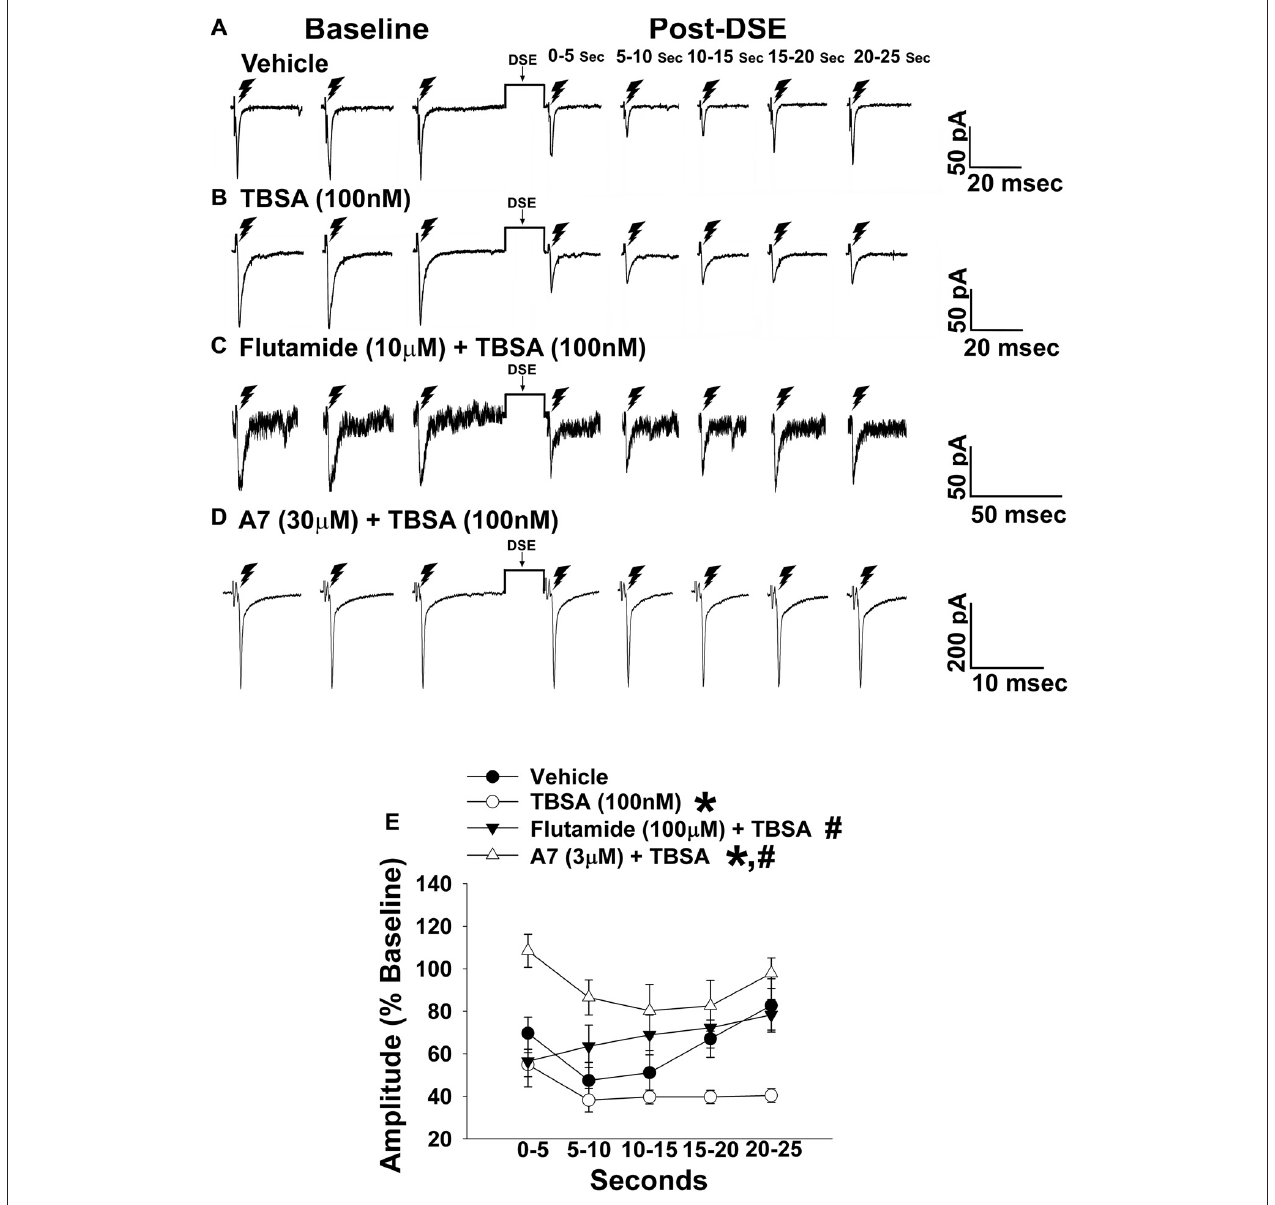
FIGURE 4 | The membrane-impermeant form of testosterone rapidly intensifies endocannabinoid (EC)-mediated reduction in eEPSC amplitude, which is blocked by a classical androgen receptor antagonist, as well as via inhibition of calcium/calmodulin-dependent protein kinase. Current membrane traces showing the decrease in eEPSC amplitude caused by postsynaptic depolarization seen in slices treated with either vehicle ( A ; n = 6) or testosterone 4-androsten-17 µ ;-ol-3-one-3 carboxymethyloxime bovine serum albumin (TBSA; 100 nM; B ; n = 8). Bath application of flutamide (10 µ M) attenuated the rapid potentiating effects of TBSA (100 nM; C ; n = 5) on the reduction in eEPSC amplitude, as did the calcium/calmodulin antagonist A7 administered via the internal solution (30 µ M; D ; n = 5). The composite line graph (E) shows the enhanced retrograde inhibition caused by TBSA. ∗ P < 0.05 relative to vehicle treated slices; rank-transformed multifactorial ANOVA/LSD. # P < 0.05 relative to slices treated with TBSA alone; rank-transformed multifactorial